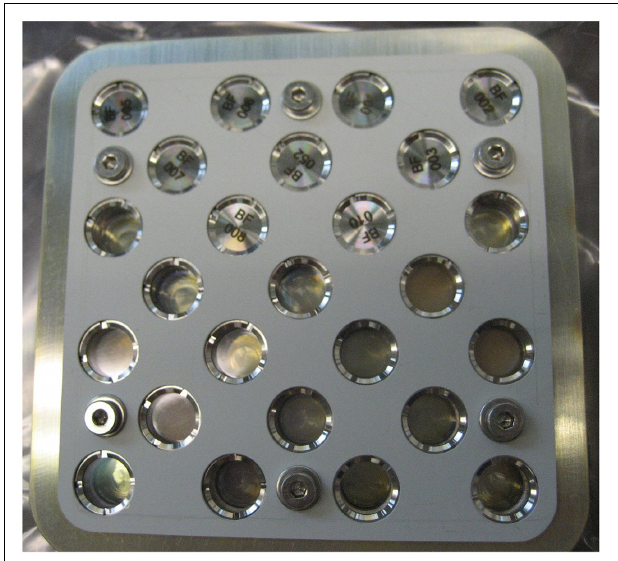
FIGURE 4 | Design of 25 cell top carrier of tray 3 P.S.S. experiment. Credit: Cottin, LISA.